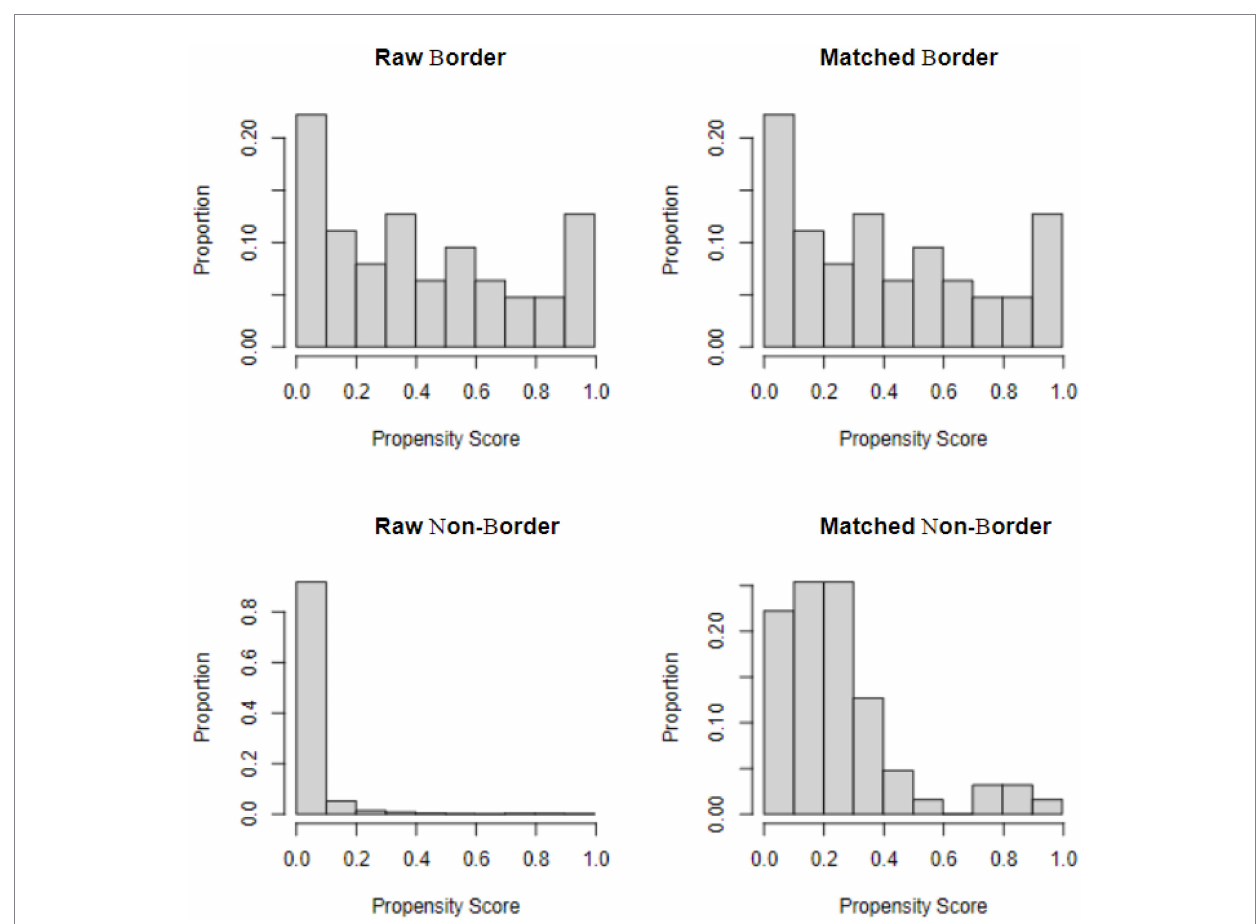
FIGURE 3 Histograms of propensity score before and after matching by condition.